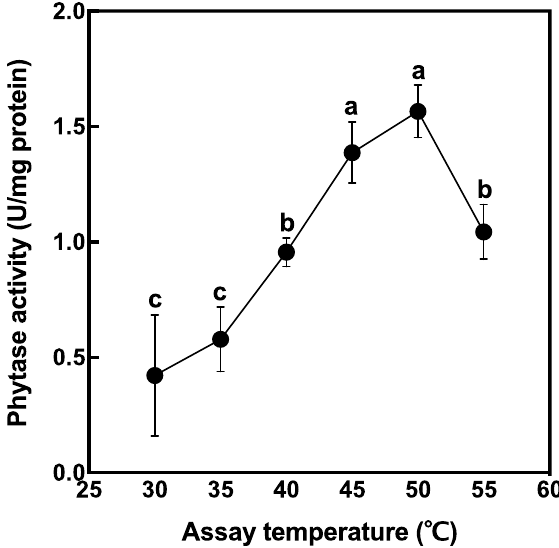
Figure 2. Phytase activity extracted from brown rice. Data are shown as the mean ± standard devi- ation from three replicates. Different letters indicate statistical differences (Tukey’s HSD test, p < 0.05) between treatments.